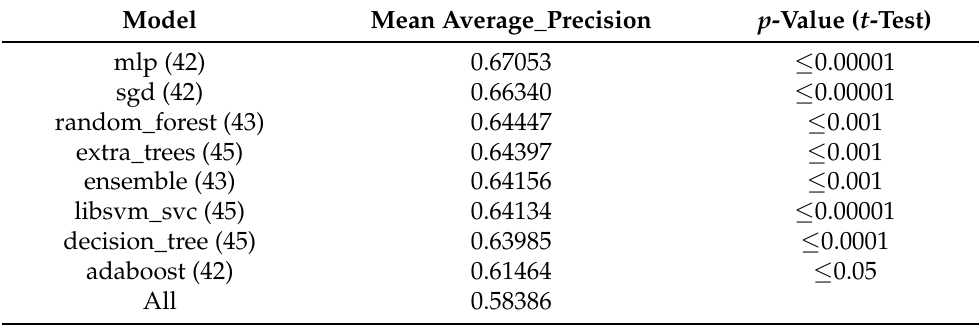
Table A3. Models with significantly better mean average precision.